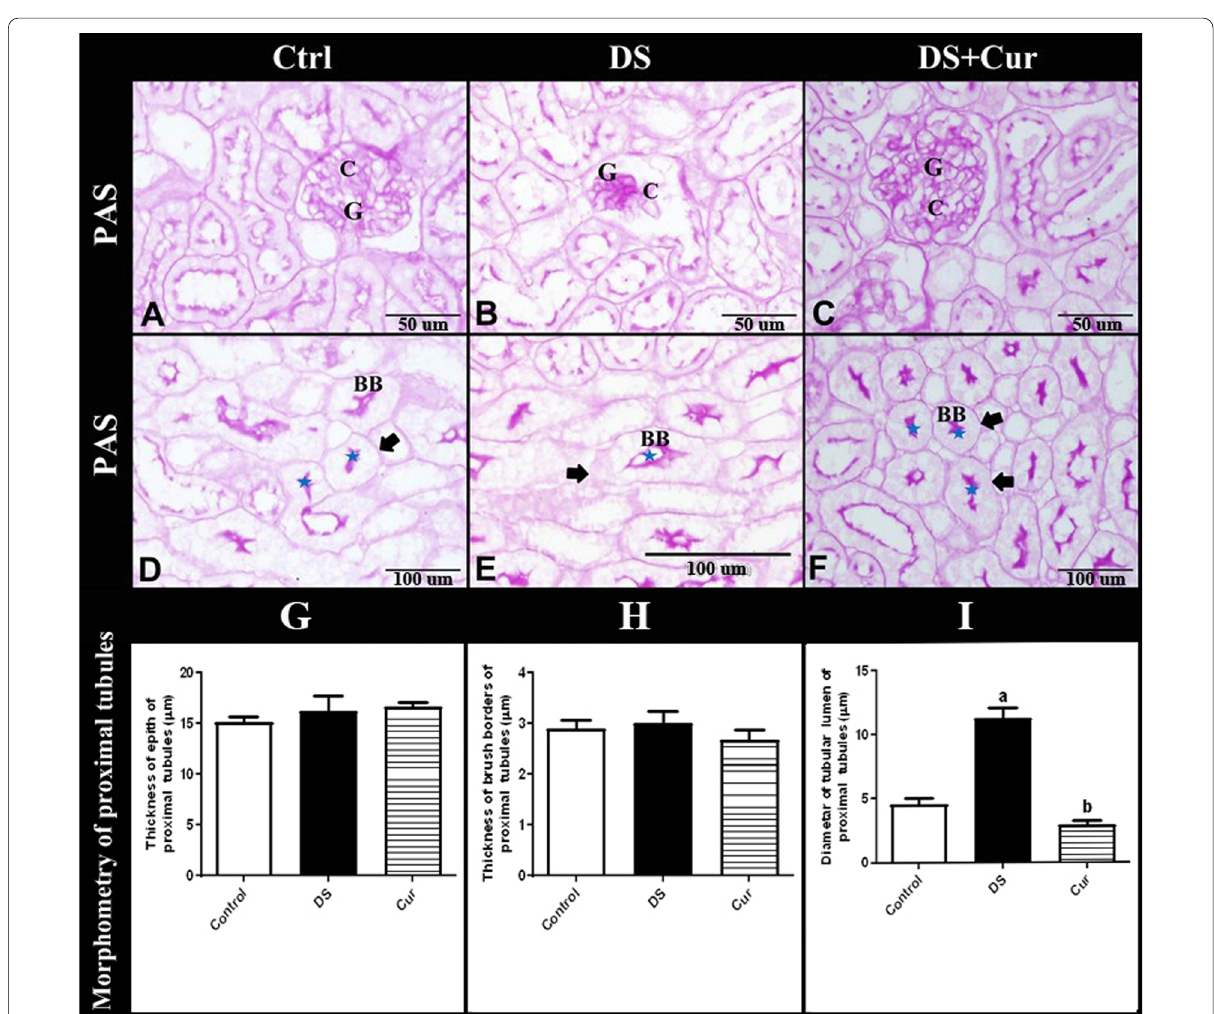
Fig. 6 Photomicrographs of paraffin sections stained with periodic acid Schiff (PAS) illustrated the protective effect of curcumin (Cur) on diclofenac sodium (DS) induced renal damage in rat. A The kidney of control (Ctrl) group showed normal‑sized glomerulus (G) and glomerular capillaries (C). B The kidney of DS group showed small‑sized glomerulus (G) and large‑sized (widened) glomerular capillaries (C). C The kidney of diclofenac sodium curcumin (DS Cur) group showed restoration of the normal‑sized glomerulus (G) and glomerular capillaries (C). D The kidney of control + + (Ctrl) group showed normal proximal tubules with intense PAS‑positive brush borders (BB), narrow lumen (blue star) and continuous healthy PAS‑positive renal tubular basement membrane (arrow). E The kidney of DS group showed proximal tubules with decreased PAS‑positive brush borders (BB), wide lumen (blue star) and disrupted renal tubular basement membrane (arrow). F The kidney of DS of the normal proximal tubules with intense PAS‑positive brush borders (BB), narrow lumen (blue star) and continuous healthy PAS‑positive renal